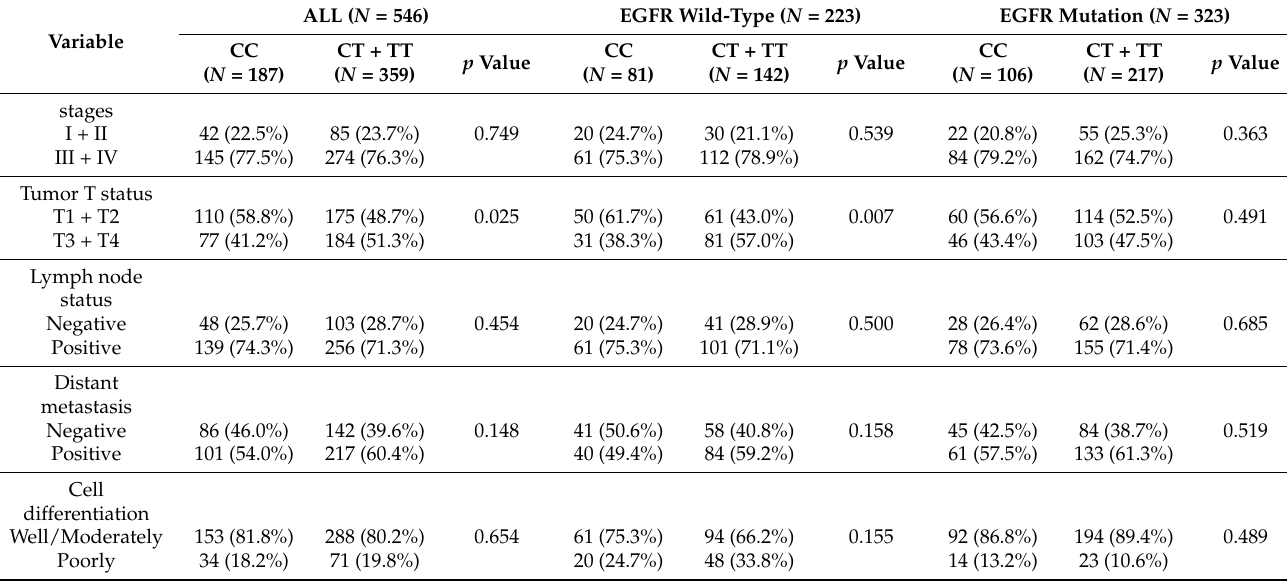
Table 5. Clinicopathologic characteristics of lung adenocarcinoma patients with EGFR mutation, stratified by polymorphic genotypes of H19